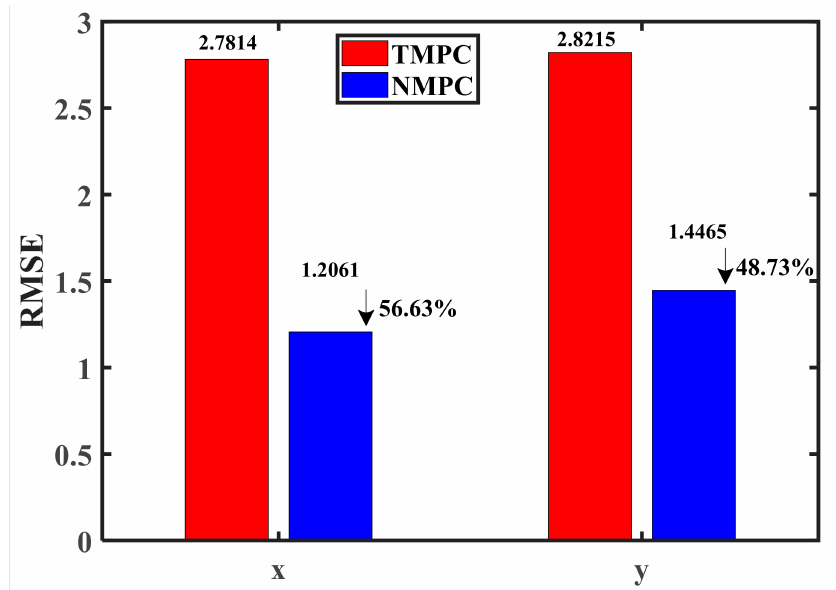
Figure 19. The histogram comparisons of two MPC controllers under the